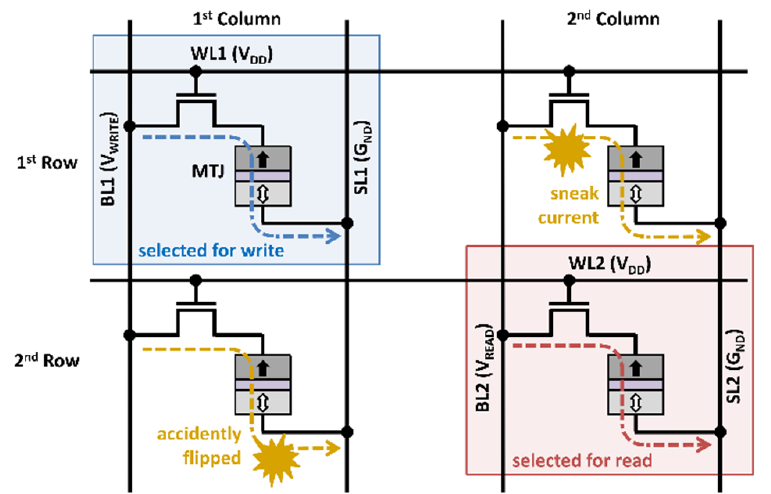
Figure 3. Simultaneous access conflict in single-port STT-MRAM in distance-2 bit-interleaving ar- chitecture.